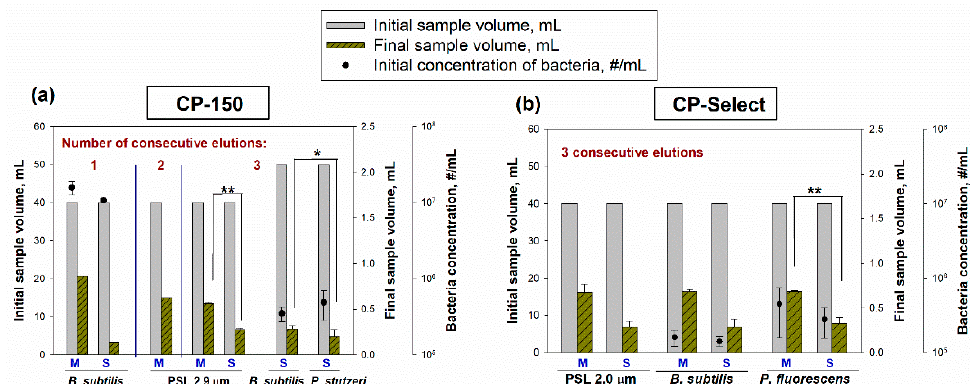
Figure 3. The final suspension volumes after concentrating 40–50 mL initial samples with two di ff erent PSL particle sizes (2.0 and 2.9 µ m, with 1% solids in suspension) and bacterial cells ( B. subtilis , P. stutzeri , and P. fluorescens ) using ( a ) the CP-150 and ( b ) the CP-Select with di ff erent elution fluid volumes (M: Medium and S: Small). The data are averages of three repeats, and the error bars represent one standard deviation. * p < 0.05, ** p < 0.001, and p values are based on multiple pairwise comparisons using the Holm–Sidak method, and p values are analyzed by one-way ANOVA. ( a ). Initial and final suspension volumes determined by the CP-150; ( b ). Initial and final suspension volumes determined by the